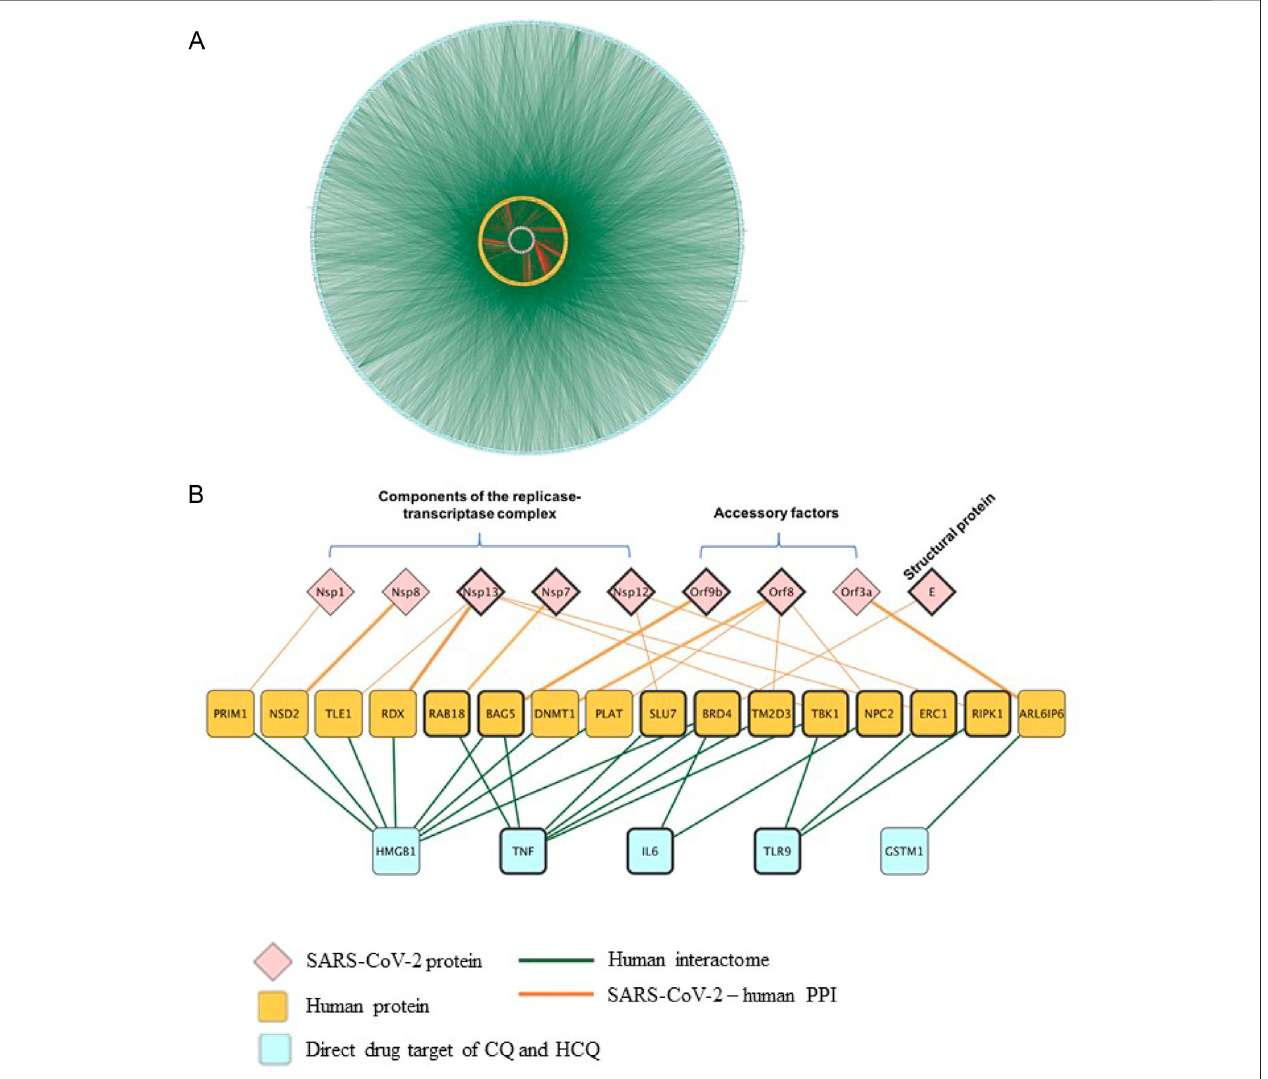
FIGURE 7 | The identi fi cation of the interactions between TLR9 and Nsp12/Nsp13 in SARS-CoV-2-host interactome. (A) Interactions between SARS-CoV-2 proteins with their direct human protein partners (green line: human interactome; yellow circle: human proteins; red line: SARS-CoV-2-human PPI). (B) A close-up view showing the interactions between the CQ and HCQ drug targets and human proteins that were found to interact with SARS-CoV-2 proteins.